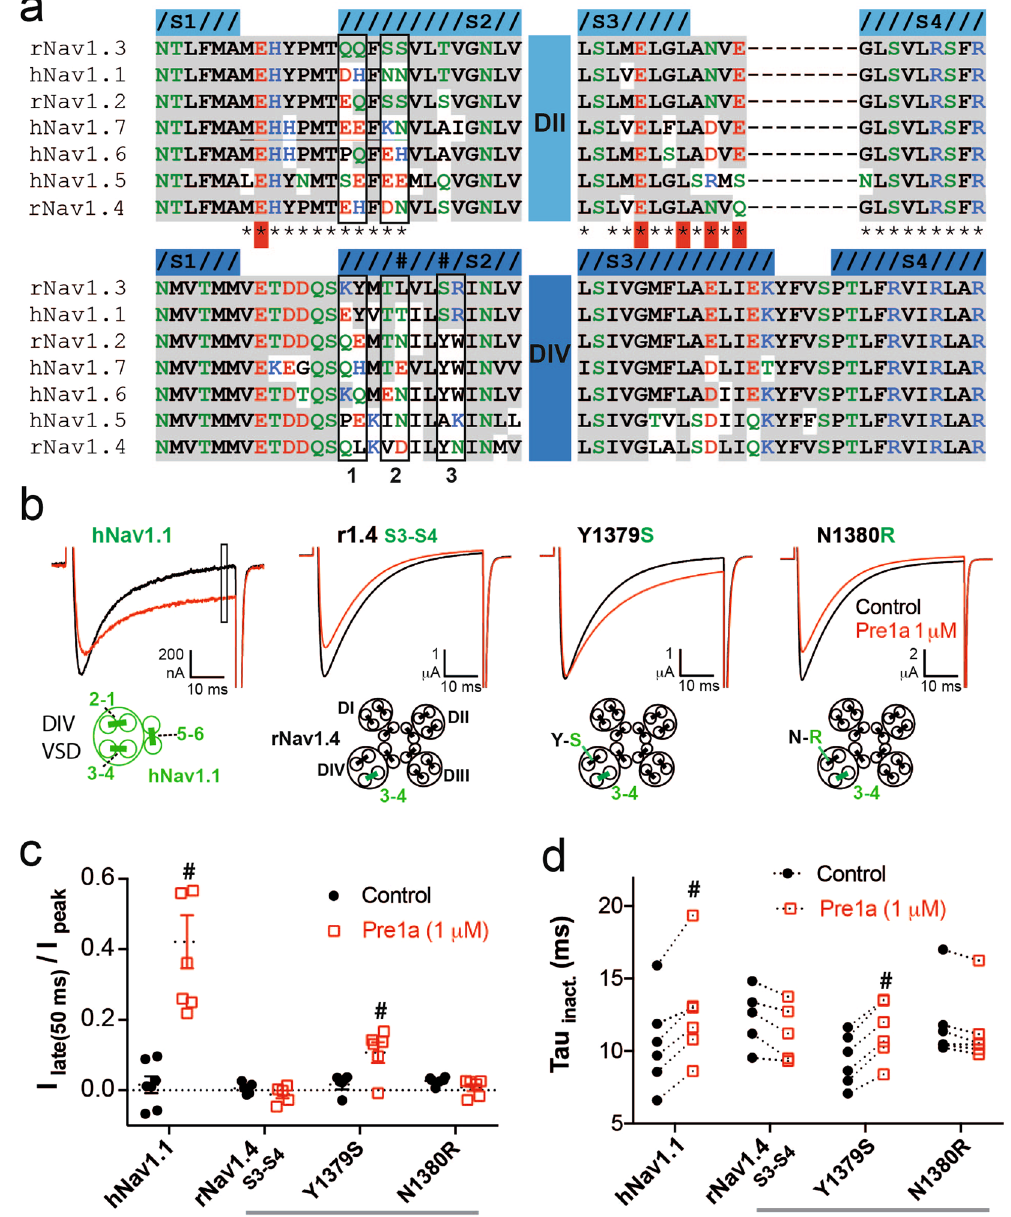
Figure 7. The S3-S4 linker alone accounts for the subtype selectivity of Pre1a. ( a ) Alignment of DII and DIV extracellular linkers S1-S2 and S3-S4 for Na V channel isoforms used in this study. Grey shading indicates identity to rNa V 1.3 for both domains, residue colouring indicates; blue = basic/positive, red = acidic/negative, green = polar, black = hydrophobic. Helices are defined based on the structures of rabbit Ca V 1.1 (PDB: 5GJV) for DII, and the Na V Ab/hNa V 1.7 chimaera (PDB: 5EK0) for DIV. * Indicates residues mutated in DII by Xiao et al . 23 , red highlight indicates importance for HwTxIV interaction. (b ) Representative traces showing the effect of 1 µ M Pre1a on hNa V 1.1 and chimaeras of rNa V 1.4 containing the S3-S4 linker region of Nav1.1 DIV, and additional Na V 1.4 to 1.1 point mutants in the adjacent S1-S2 linker (schematics illustrating the chimaera constructions are shown below the respective current trace). (c ) Normalised effect of Pre1a on the late current of channels in B (n = 5–6). (d ) Effect of Pre1a (1 μ M) on the Tau of current inactivation (determined from single exponential fit) for channels shown in 7B (n = 5–6). # P < 0.05 Wilcoxon paired